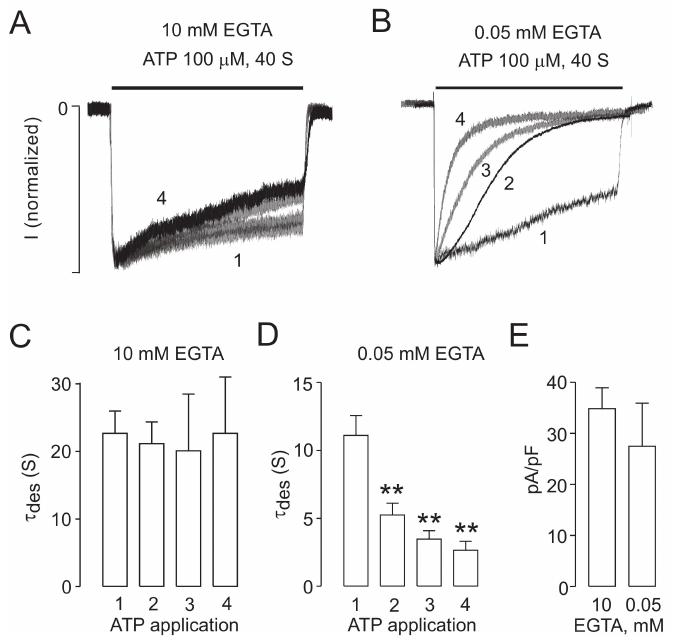
Figure 3. Use-dependent desensitization on PC12 cells. ( A ) Representative tracings of a single PC12 cell challenged with four successive applications of 100 µ M ATP and the intracellular solution containing 10 mM EGTA; ( B ) The same experiment in other PC12 cells in which the intracellular solution includes 0.05 mM EGTA; UDD is developed under such conditions; ( C , D ) Summary of the desensitization constants in four consecutive ATP applications in cells clamped with an intracellular solution containing 10 mM ( C ) or 0.05 mM ( D ) EGTA; ( E ) Current densities for both conditions. ** p < 0.01, test. Mann-Whitney test. n = 4–8.